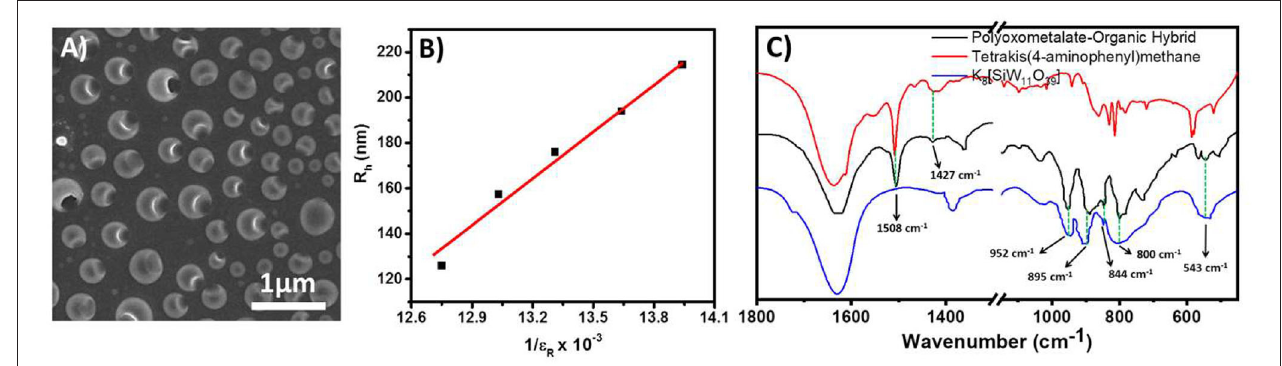
FIGURE 3 | (A) SEM image of the hollow vesicles of the hybrid prepared in water, DMSO mixture. (B) Plot of soft-oxometalate vesicle radius with respect to the inverse dielectric constant of the solvent mixture. (C) Comparison of IR spectra of oxometalate hybrid, tetrakis(4-aminophenyl)methane, and [SiW 11 O 39 ] 8 − .